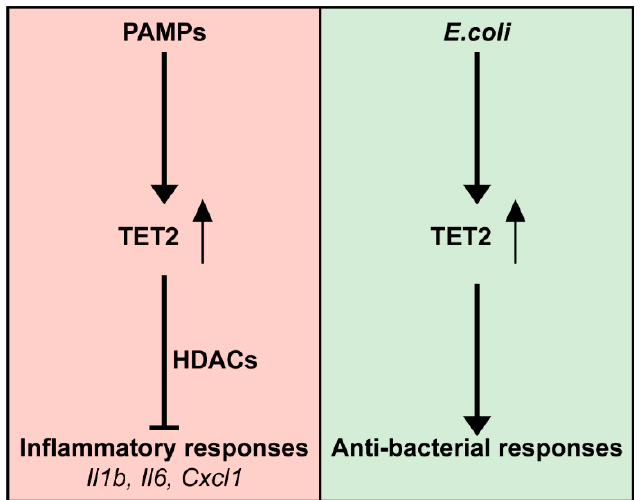
Figure 7. The role of TET2 in myeloid cells during PAMPs stimulation and E. coli infection. PAMPs stimulation induces TET2 expression, resulting in downregulation of inflammatory mediators (such as Il1b , Il6 and Cxcl1 ) in a HDACs dependent manner; TET2 is induced during E. coli infection and contributes to myeloid cell-mediated host anti-bacterial defense. PAMPs: Pathogen-associated molecular pattern molecules; TET2: Tet methylcytosine dioxygenase 2; HDACs: Histone deacetylases. Tet2 has been reported to be induced by NF– κ B activation (14). In agreement, we